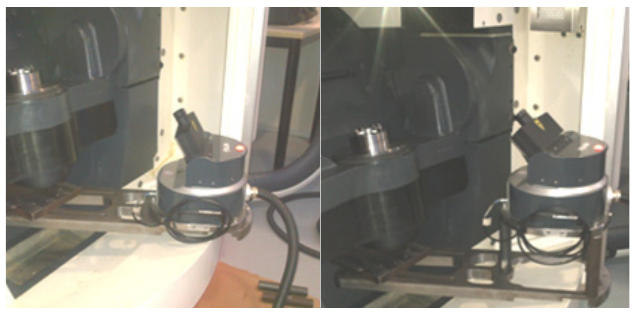
Figure 4. Two tracking laser (TL) positions.